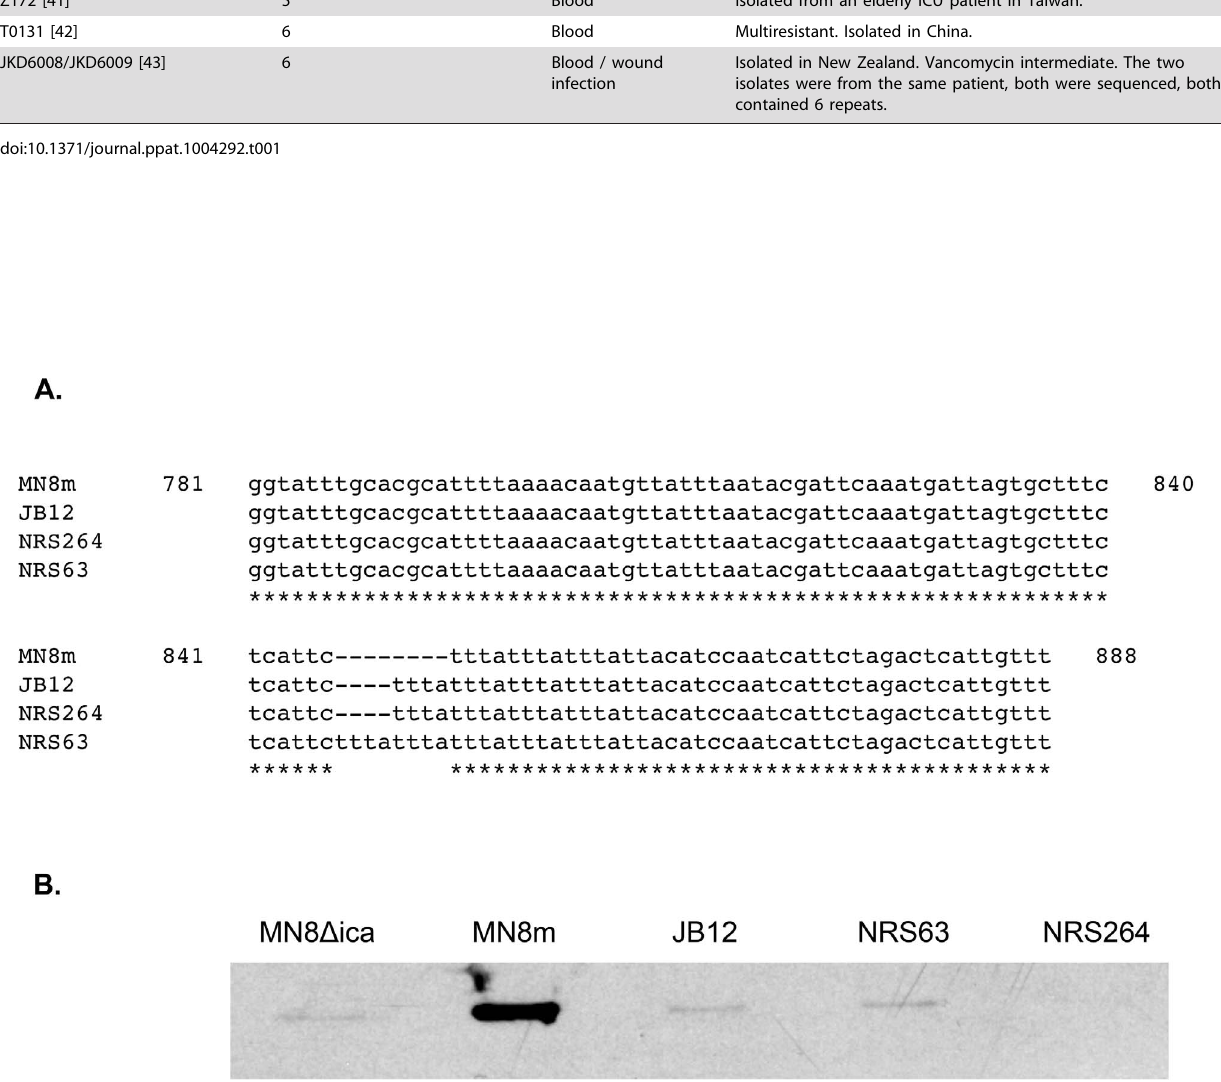
Figure 5. Evidence of icaC tandem repeat variation in clinical S.aureus isolates, and the effect on PNAG production. A. Nucleotide sequence alignment of the region of repeats identified in icaC , comparing mucoid MN8m and non-mucoid isolate JB12 with two published sequences of S. aureus clinical isolates, NRS63 and NRS264. B. PNAG slot blot analysis of S. aureus strains MN8, MN8 D ica, MN8m, JB12, NRS63, and NRS264 probed with PNAG-specific polyclonal antiserum. Due to the very high levels of PNAG produced by MN8m, cell surface extracts from this strain were diluted 1:100 prior to immobilization on membrane.